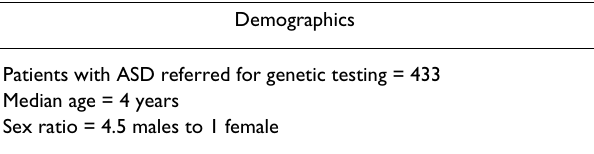
Table 1: Demographics of the ASD patients tested